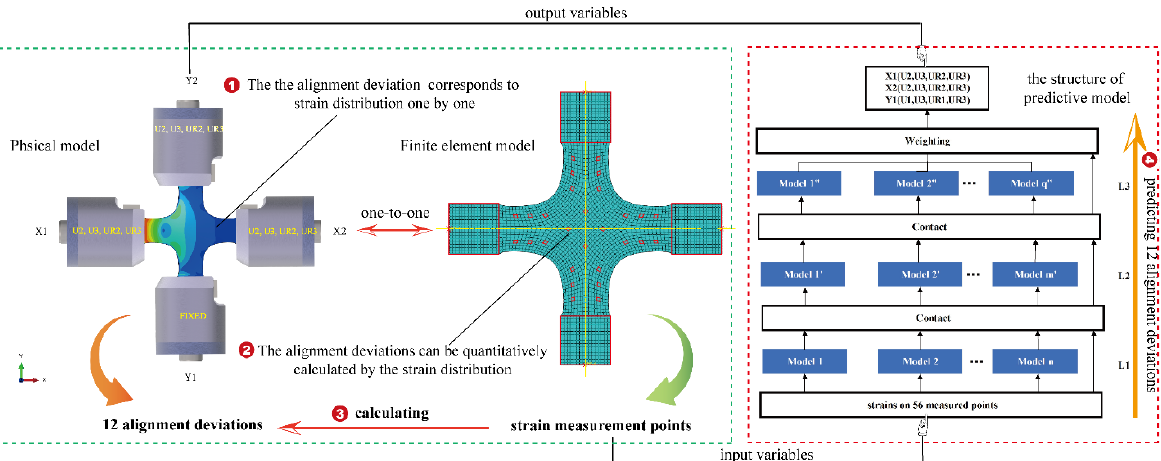
Figure 12. Prediction process of biaxial alignment deviation of the plane biaxial tensile testing machine.